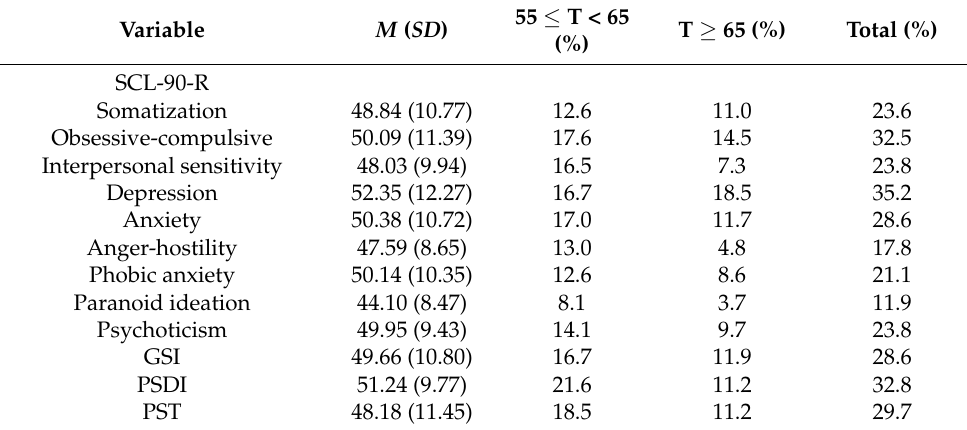
Table 3. Mean scores ( SD ) of SCL-90-R and percentage of pathological